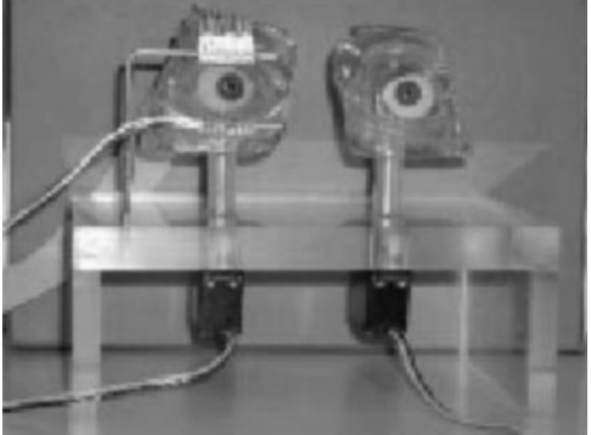
Figure 11 Experimental